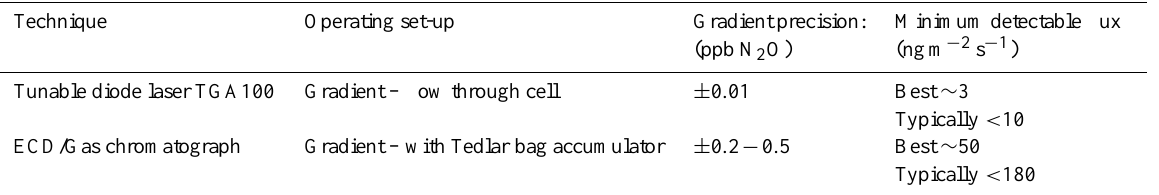
Table 1. Summary of instrument specifications.